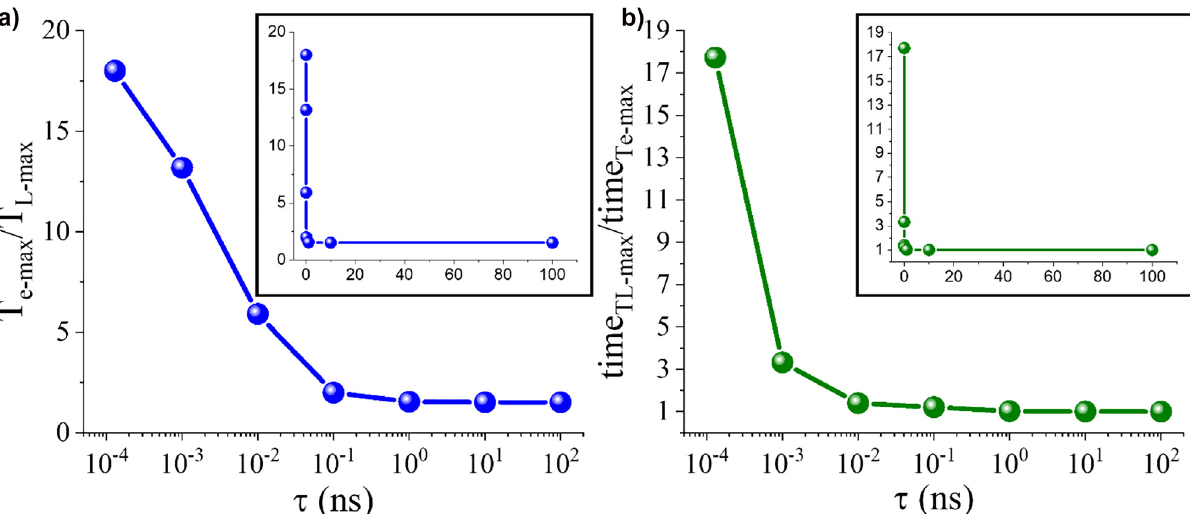
Figure 6: Figures of merit for temperature dynamics of hot electrons. (a) The ratio of the maximum electron over lattice temperature. (b) The ratio of the time when T e-max occurs over the time when the lattice temperature reaches to T L-max . Both ratios are plotted in logarithmic scale as a function of the incident pulse duration. These results are calculated from the data presented in Figure 5. The insets show the corresponding plots in linear scale. All the data are calculated in the point P shown in the inset of Figure